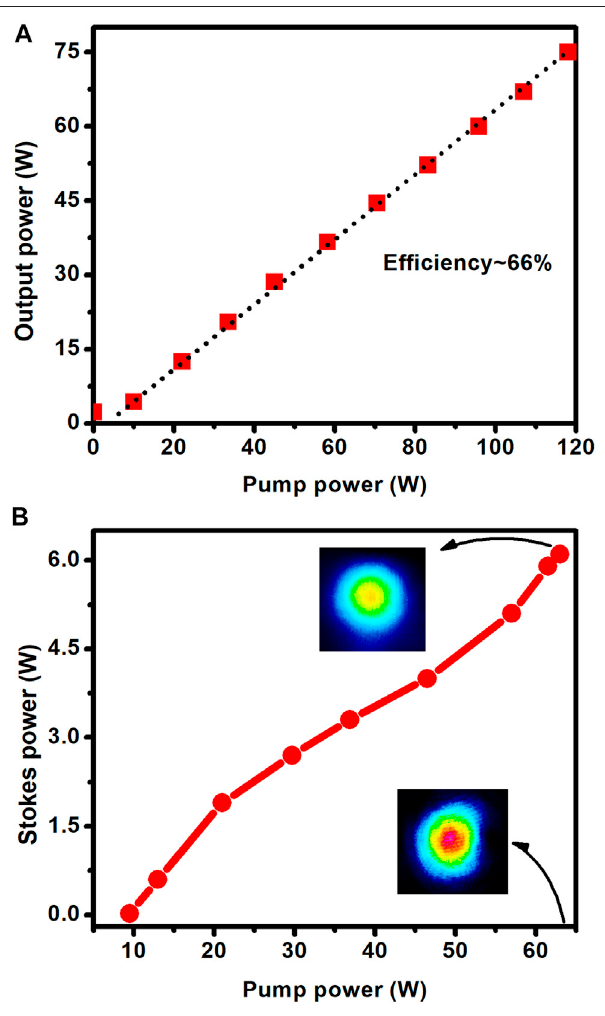
FIGURE 2 | (A) The output power of the fi ber ampli fi er as a function of pump power. (B) Measured 1,178 nm Stokes power as a function of the incident pump power; inset: beam pro fi les for Stokes (top) and pump (bottom) at the maximum power.